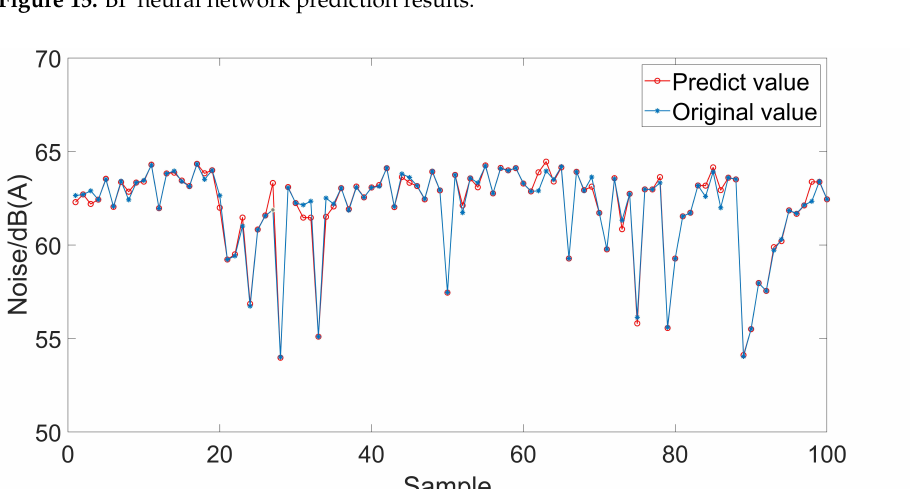
Figure 15. BP neural network prediction results.